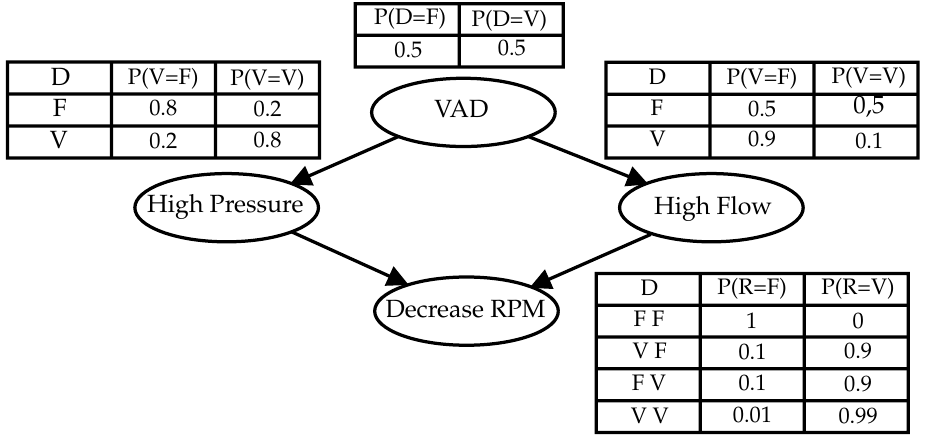
Figure 4. Example of the partial modeling of a safety system using BN. The VAD considers that two events might happen: high arterial pressure and high blood flow. Each event has the same probability of happening. These two events combined can cause a decrease in the VAD motor rotation. This is just an example, and the possible events are in a much larger